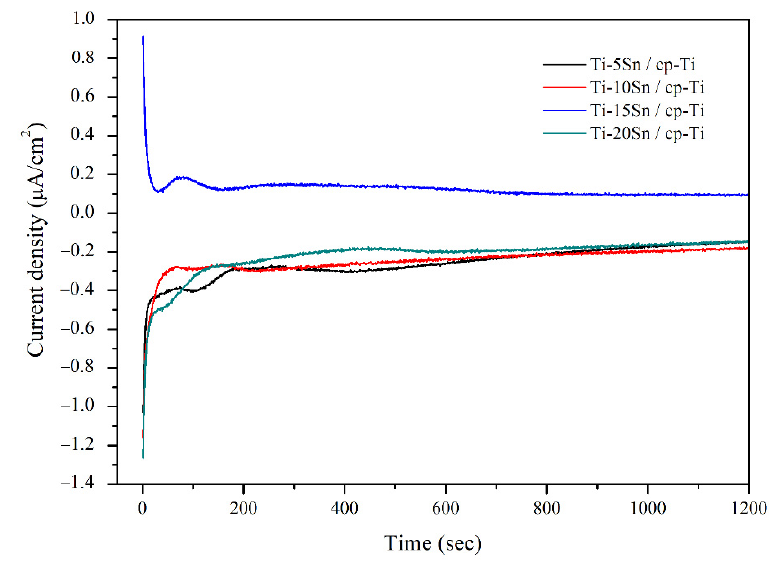
Figure 8. The galvanic current curves of Ti-Sn alloy/cp-Ti couples in 0.9% NaCl solution at 37 °C. Table 4. Galvanic current densities of Ti-Sn alloy/cp-Ti couples versus test time ( n =